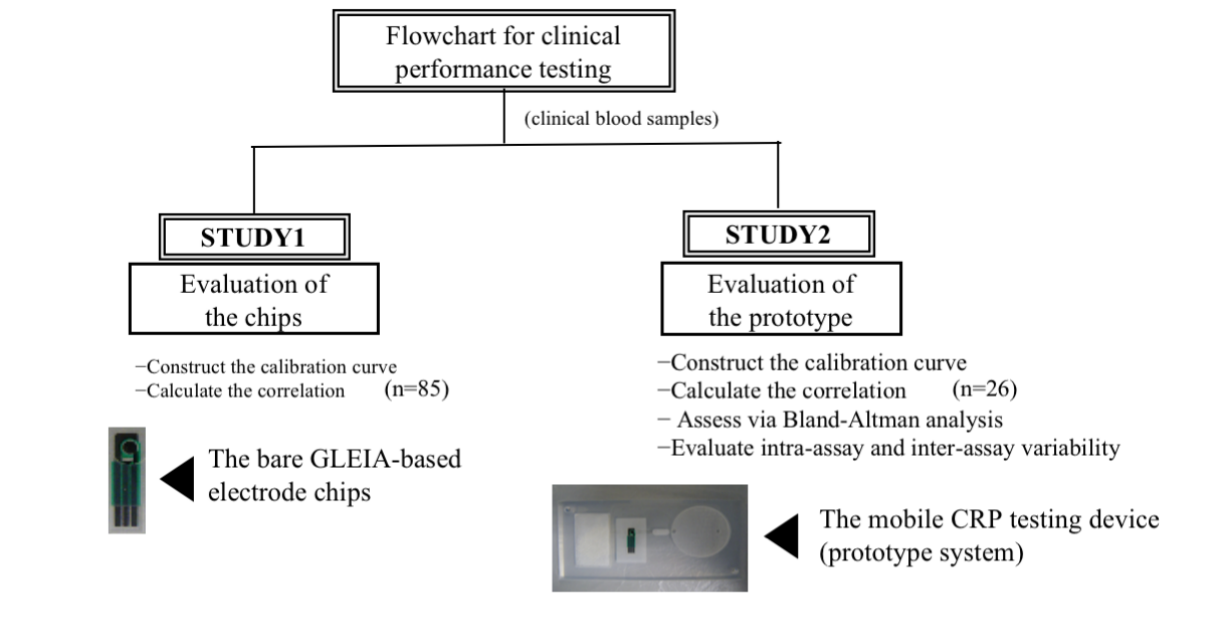
Figure 1. Flowchart of the clinical performance tests. CRP: c-reactive protein; GLEIA: gold-linked electrochemical immunosorbent assay.